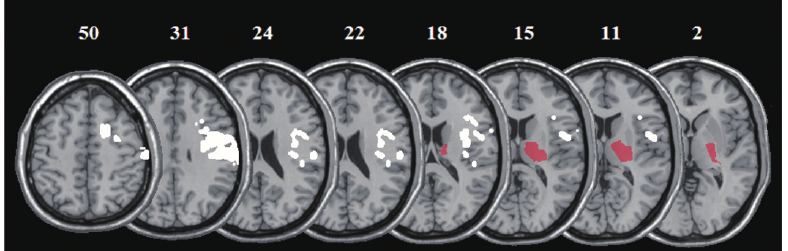
Fig. 2. The fi gures shows, in red, the center of overlap of the lesions of pure SP patients (the center is de fi ned as regions commonly damaged in 100% of patients) and, in white, regions most commonly associated with AHP [24].